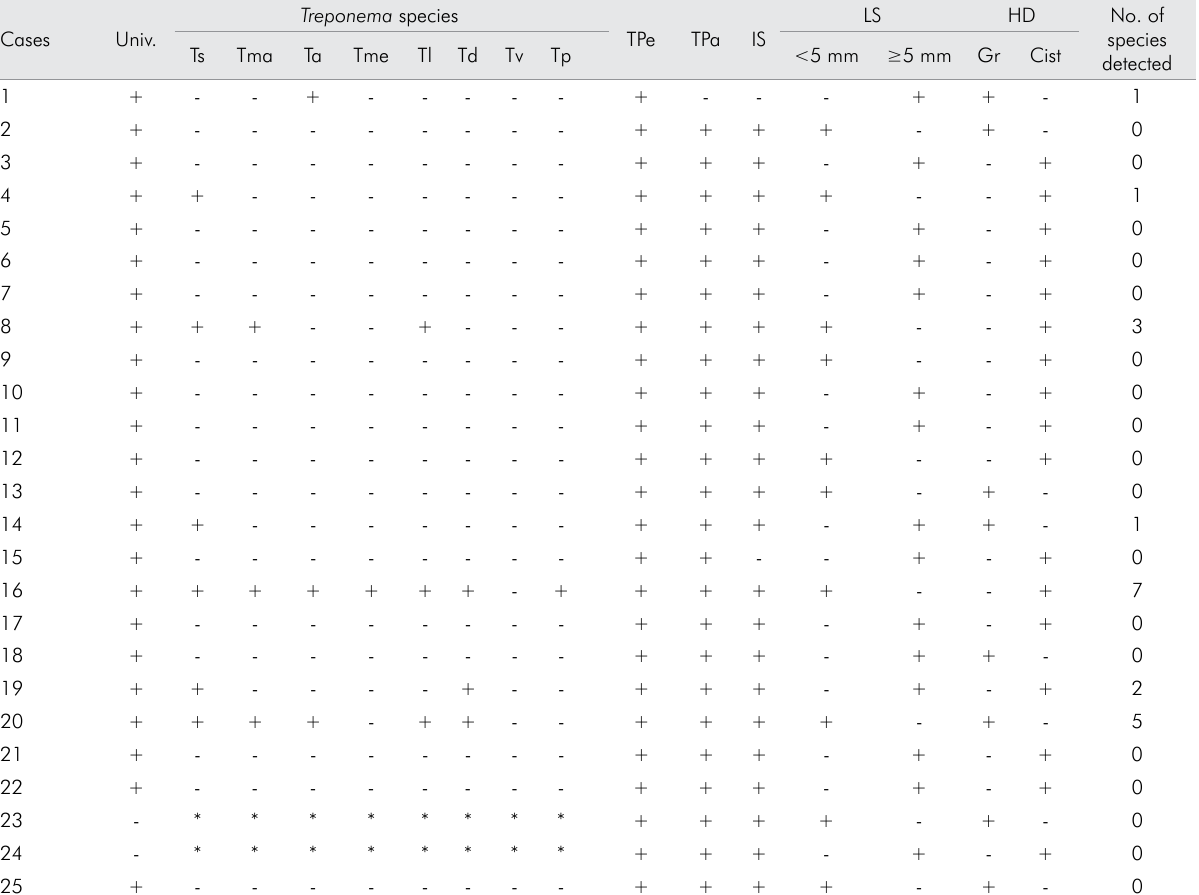
Table 2. Clinical and radiographic features, Treponema detection and histopathological diagnosis found in 25 lesions associated with persistent apical